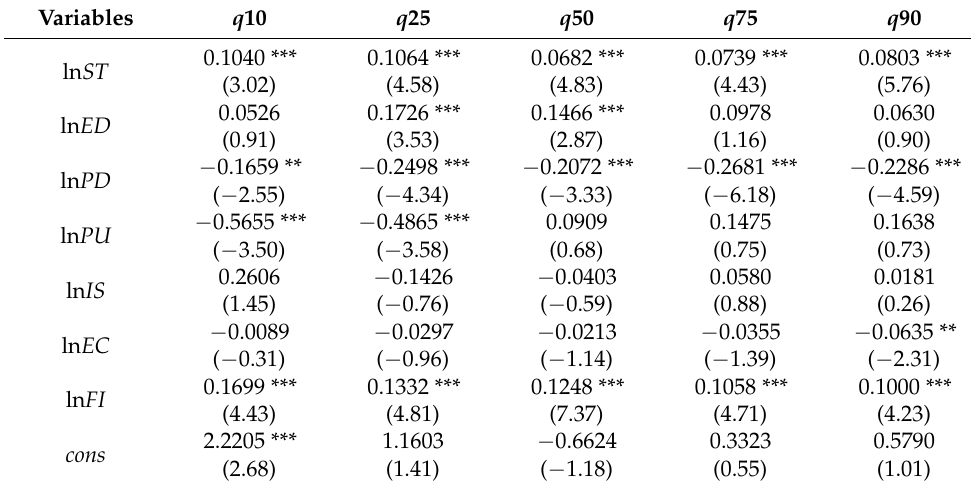
Table 8. Robustness test